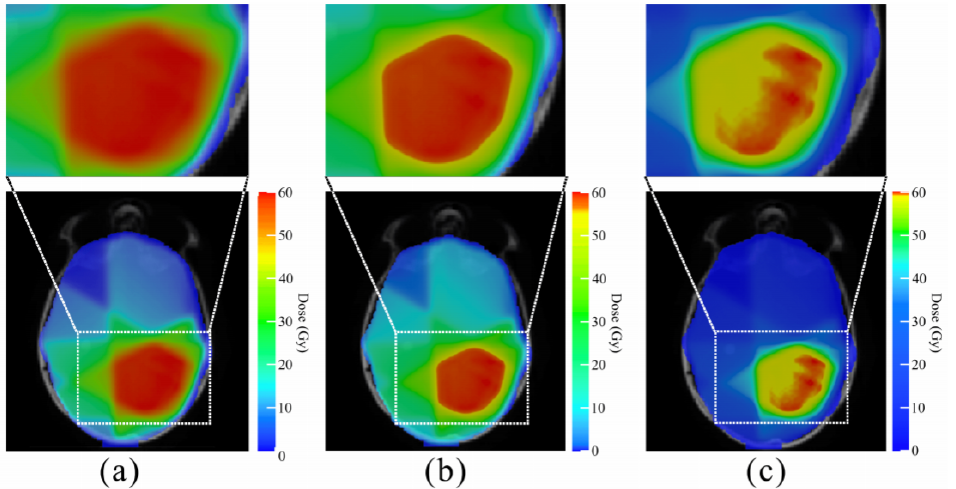
Figure 6. Two-dimensional scalar field visualization [31]. The redder the color, the higher the dose, and the bluer the dose lower. Figure ( a ) is the color map in the rainbow-coded radiotherapy dose data. Figures ( b , c ) show the optimization results before and after applying the ROI exploration